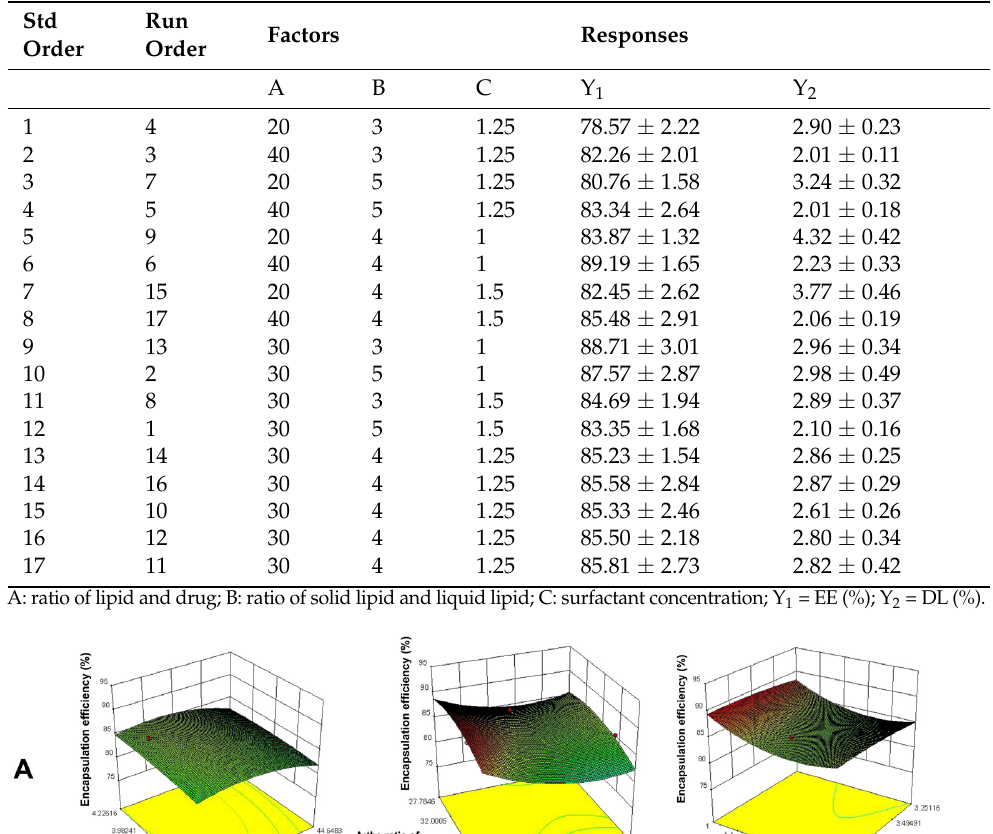
Table 1. Matrix and response values for the BBD method for KA-NLC optimization.